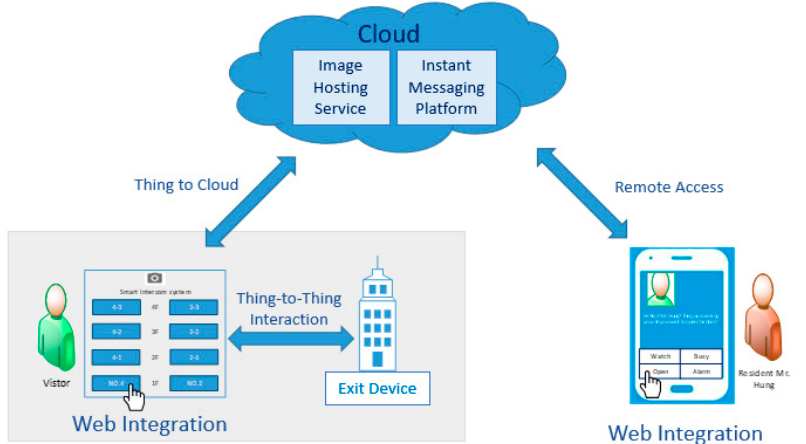
Figure 2. Schematic diagram of the smart intercom system.